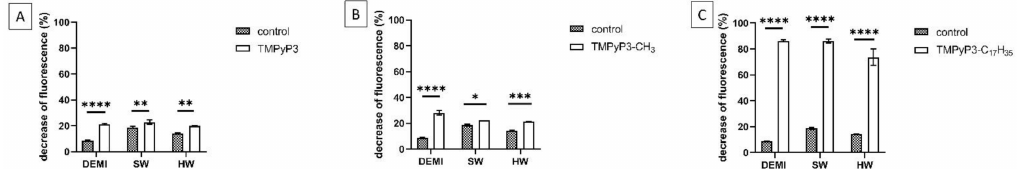
Figure 6. Singlet oxygen production of TMPyP3 ( A ), TMPyP3-CH 3 ( B ), and TMPyP3-C 17 H 35 ( C ) in different water samples (DEMI, SW, HW) (1 µ M solution) measured by photodegradation of 9,10-anthracenediyl-bis(methylene)dimalonic acid (ABMDMA) (6 µ M) after 10 min irradiation (411 nm, fluence rate 3.5 mW/cm 2 , total light dose 2.1 J/cm 2 ). The photodegradation of ABMDMA without the presence of PSs in different water samples was used as a control. Data on graphs are presented as a measurement average, with error bars presenting SD; **** p < 0.0001, *** 0.0001 < p < 0.001, ** 0.001 < p < 0.01, * 0.01 < p <